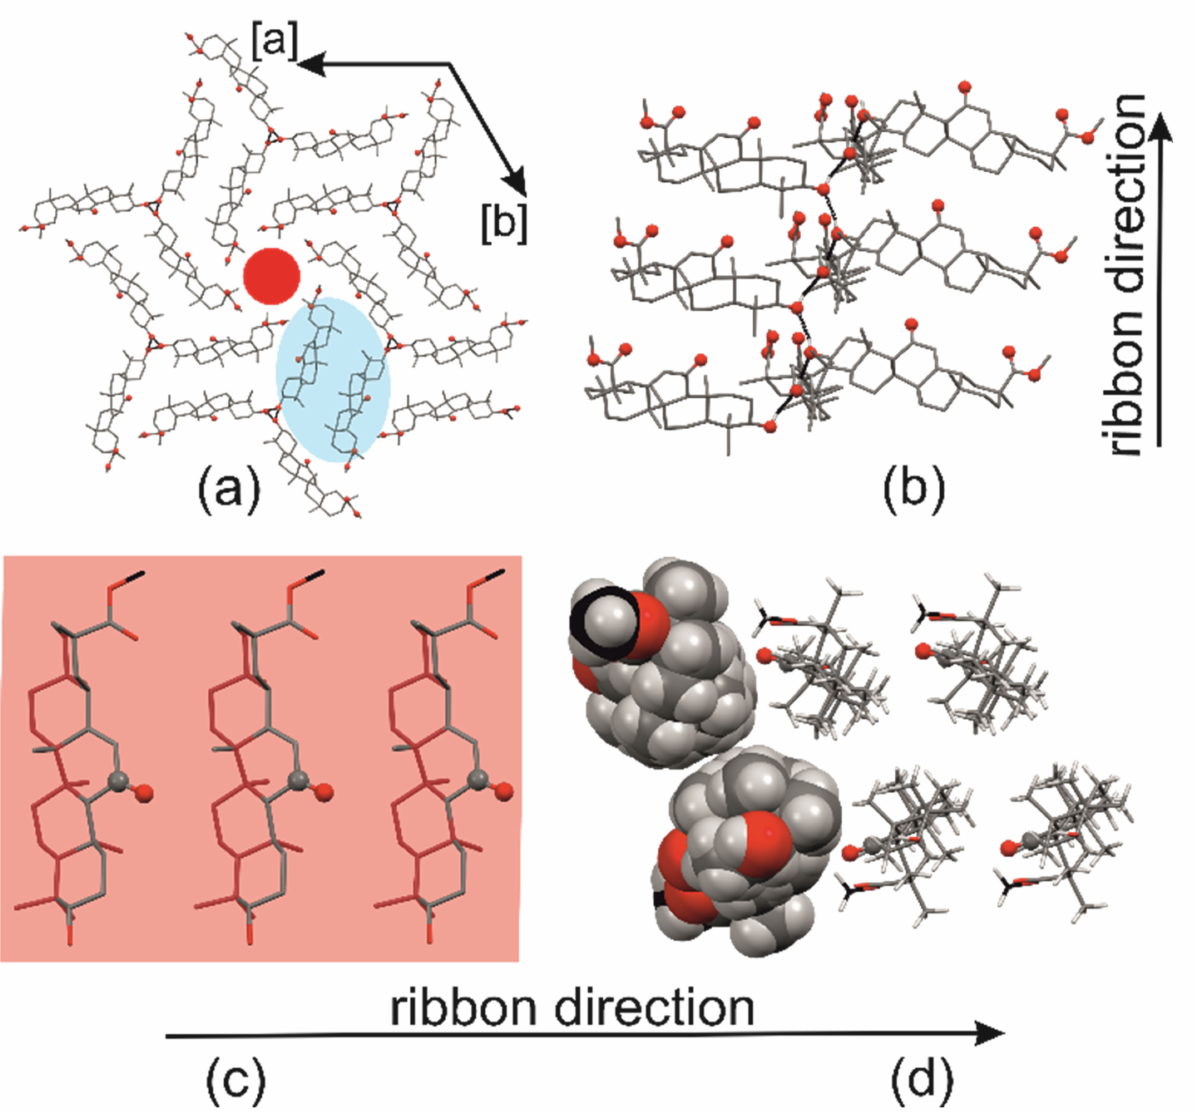
Figure 10. Me-GE: ( a ) three-dimensional structure, ( b ) helix, ( c ) Rb HH ribbon, and ( d ) ribbon dimer shown along triterpene long axis: In ( a ), voids between E rings are marked with red circles; the ribbon dimer is shaded with a blue ellipse. The O-H ··· O hydrogen bonds are shown as black lines in ( a , b ). In ( c ), the C11 and O11 atoms in C rings are shown as balls; the ribbons’ plane is shown in light red. In ( a – c ), H atoms are omitted for clarity. The methyl substituents are colored black in ( c , d ). Figures were prepared based on a structure with refcode FULJOM